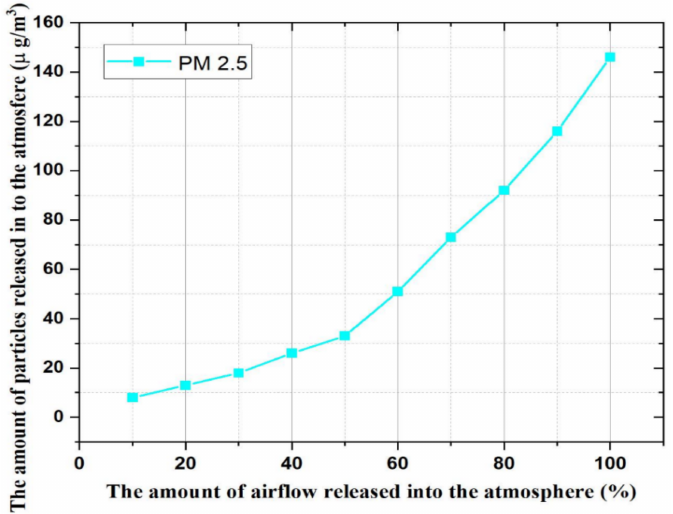
Figure 19. The secondary airflow duct that distributes the airflow separation device to the environ- ment is